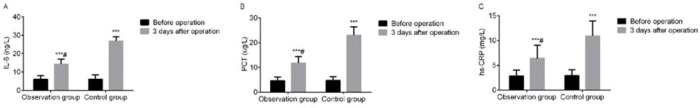
Intergroup comparison of bile inflammatory reactivity. At 3 d after LC, bile IL-6, PCT, and hs-CRP levels increased in both groups but were lower in OG than in CG (p<0.05). A: IL-6; B: PCT; C: hs-CRP. Note: ***p<0.05 versus preoperative values.